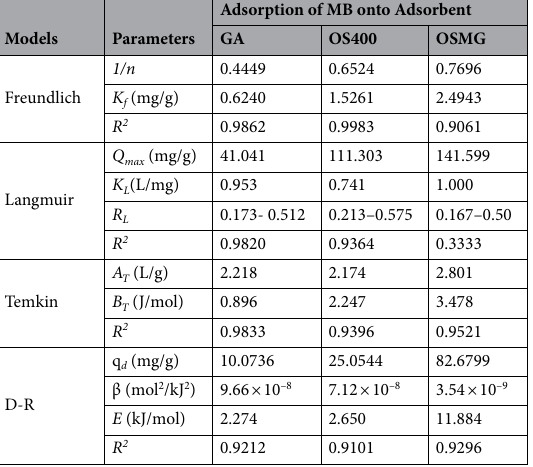
Table 5. Adsorption isotherm modeling for MB adsorption onto GA, OS400 and OSMG.